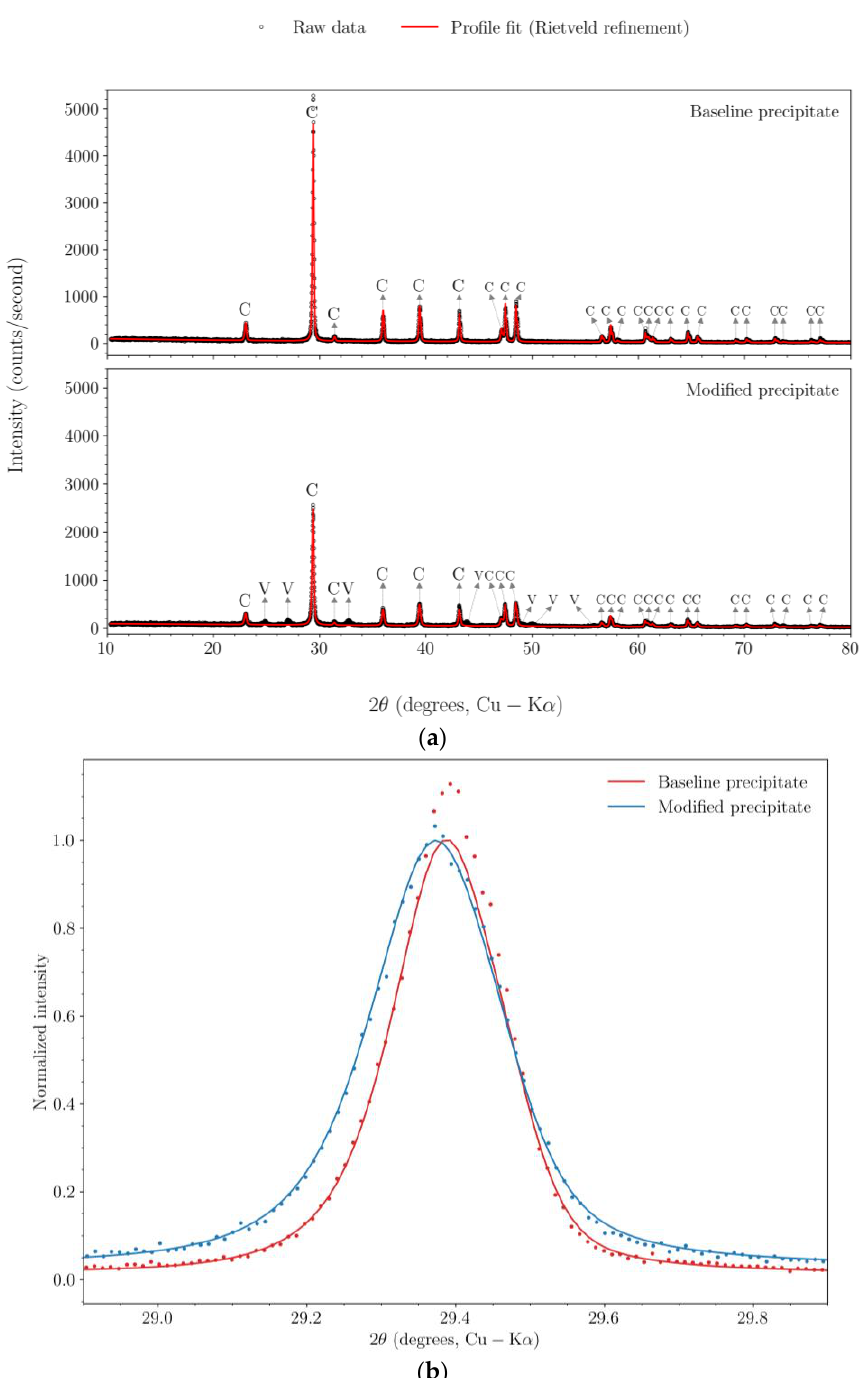
Figure 2. ( a ) X-ray diffractograms of the baseline and modified precipitate (C—calcite peaks; V—vaterite peaks). ( b ) Line broadening of calcite (104) peak in baseline and modified precipi- tates. The markers indicate experimentally measured intensities normalized by the maximum fitted intensity (using Rietveld refinement) of the calcite (104) diffraction line. Further details are presented in Section A of Supplementary